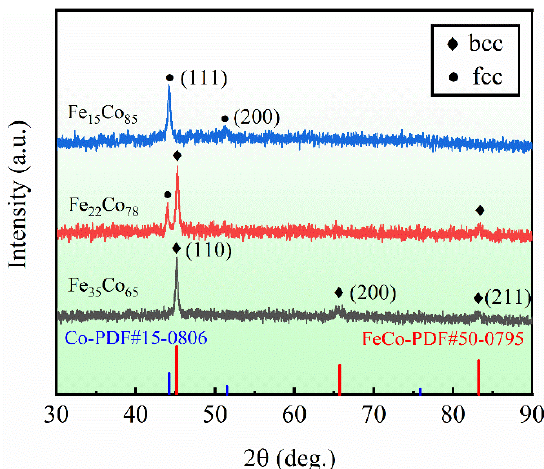
Figure 1. XRD patterns of samples Fe 35 Co 65 , Fe 22 Co 78 , Fe 15 Co 85 . The microscopic morphology and particle size of the samples were analyzed by SEM.